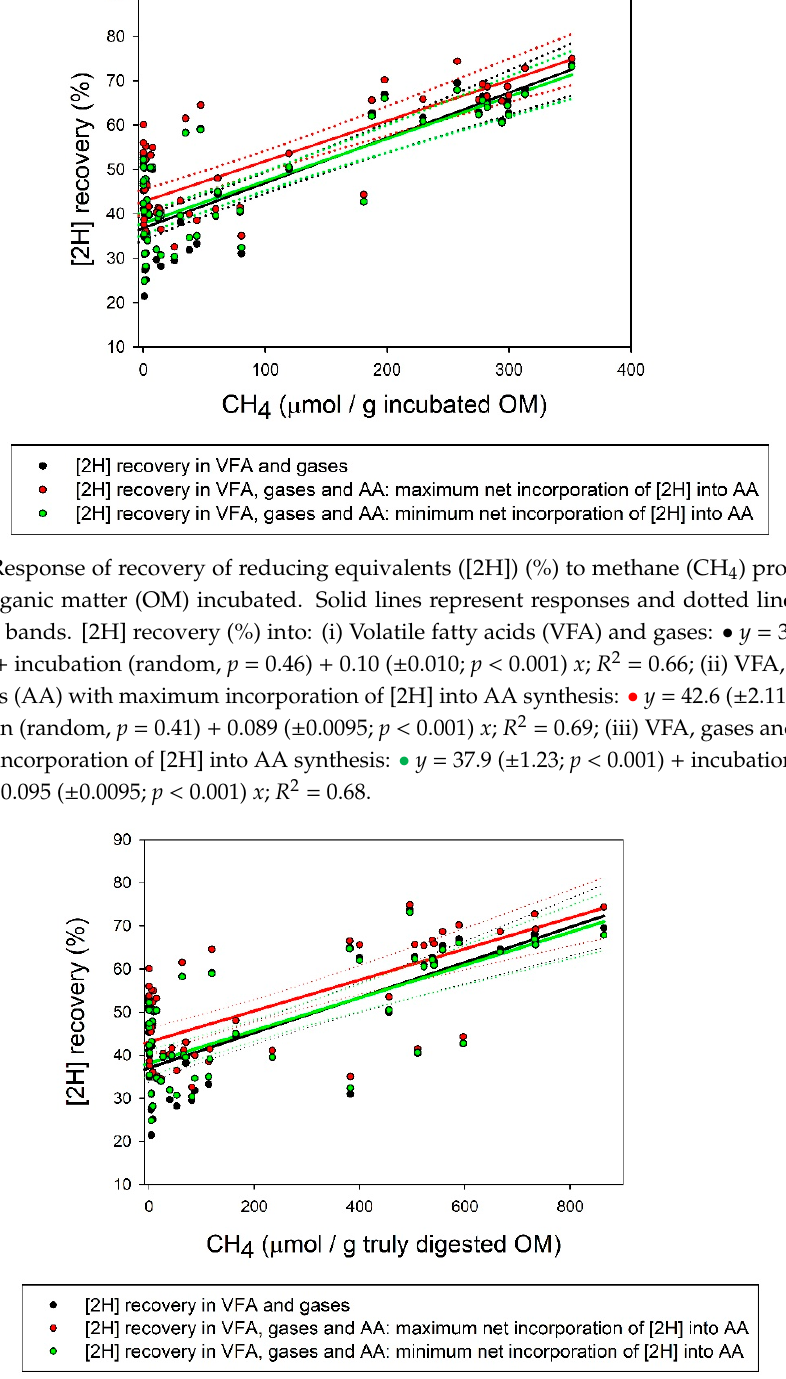
Figure 2. Response of recovery of reducing equivalents ([2H]) (%) to CH 4 produced per gram of OM truly digested. Solid lines represent responses and dotted lines are 95% confidence bands. [2H] recovery (%) into: (i) VFA and gases: • y = 37.0 ( ± 1.82; p < 0.001) + incubation (random, p = 0.77) +